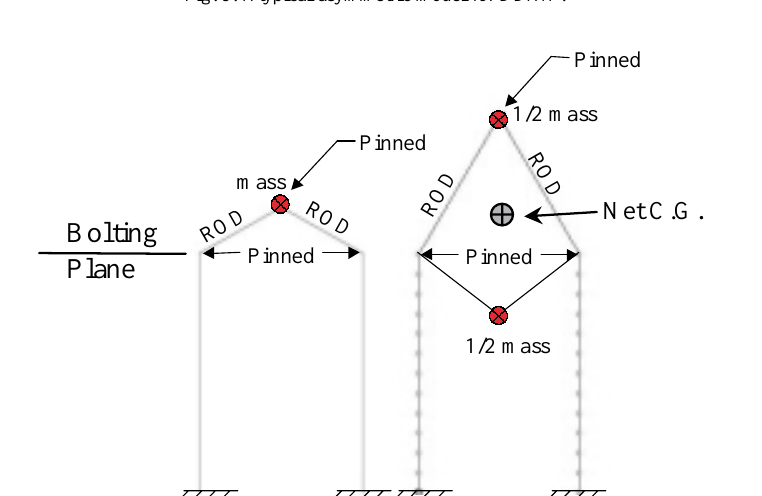
Fig. 3. Atypical asymmetric model for DDAM.